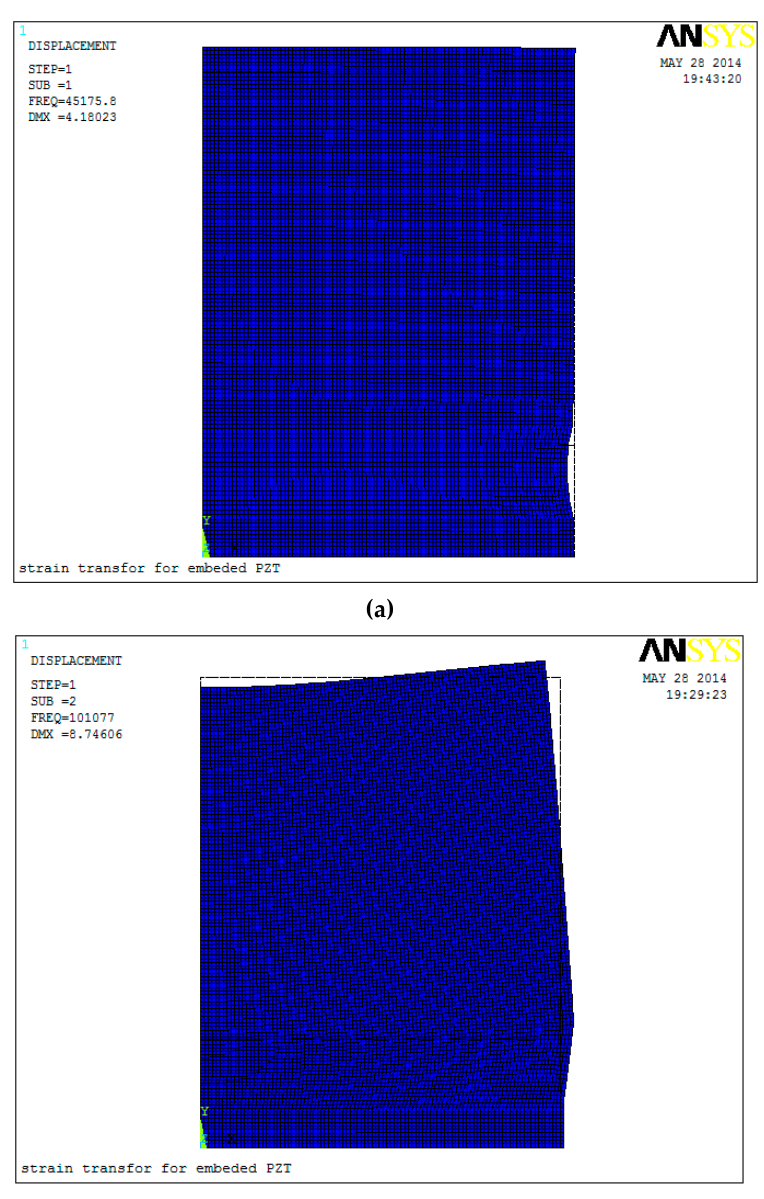
Figure 3. Cont. Figure 3.